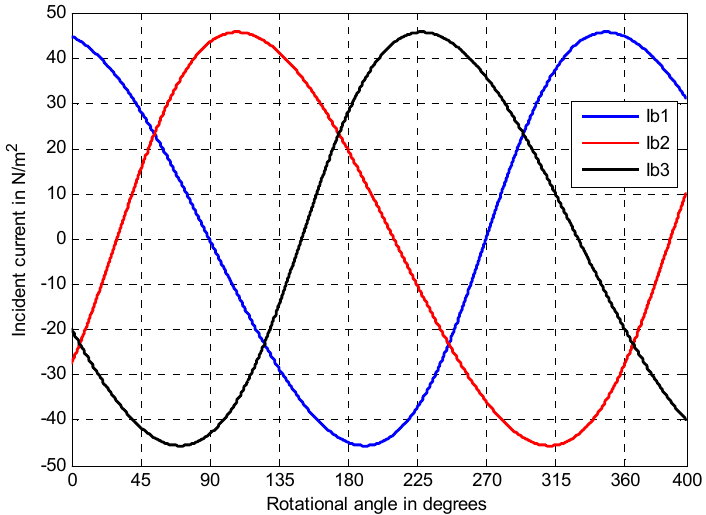
Figure 13. Incident current variations as functions of the rotational angle.